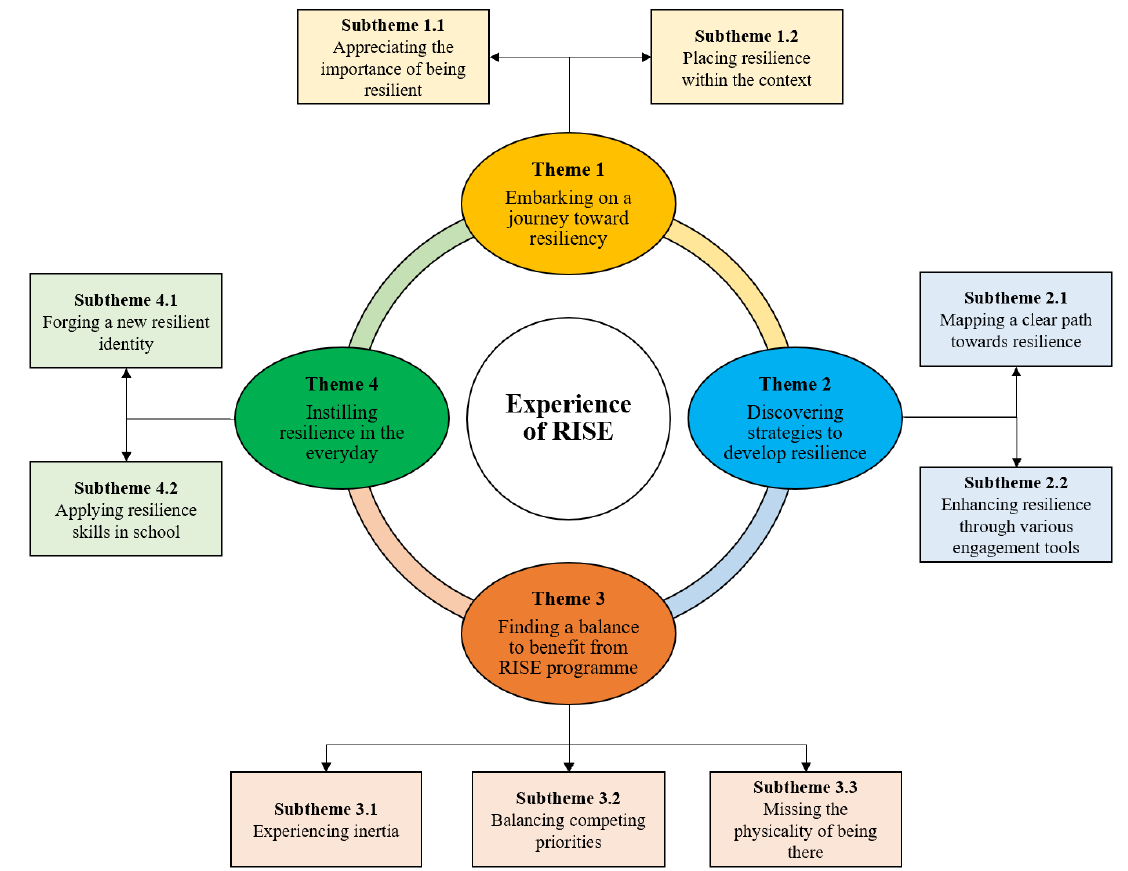
Figure 3. Students’ experience of the RISE program .